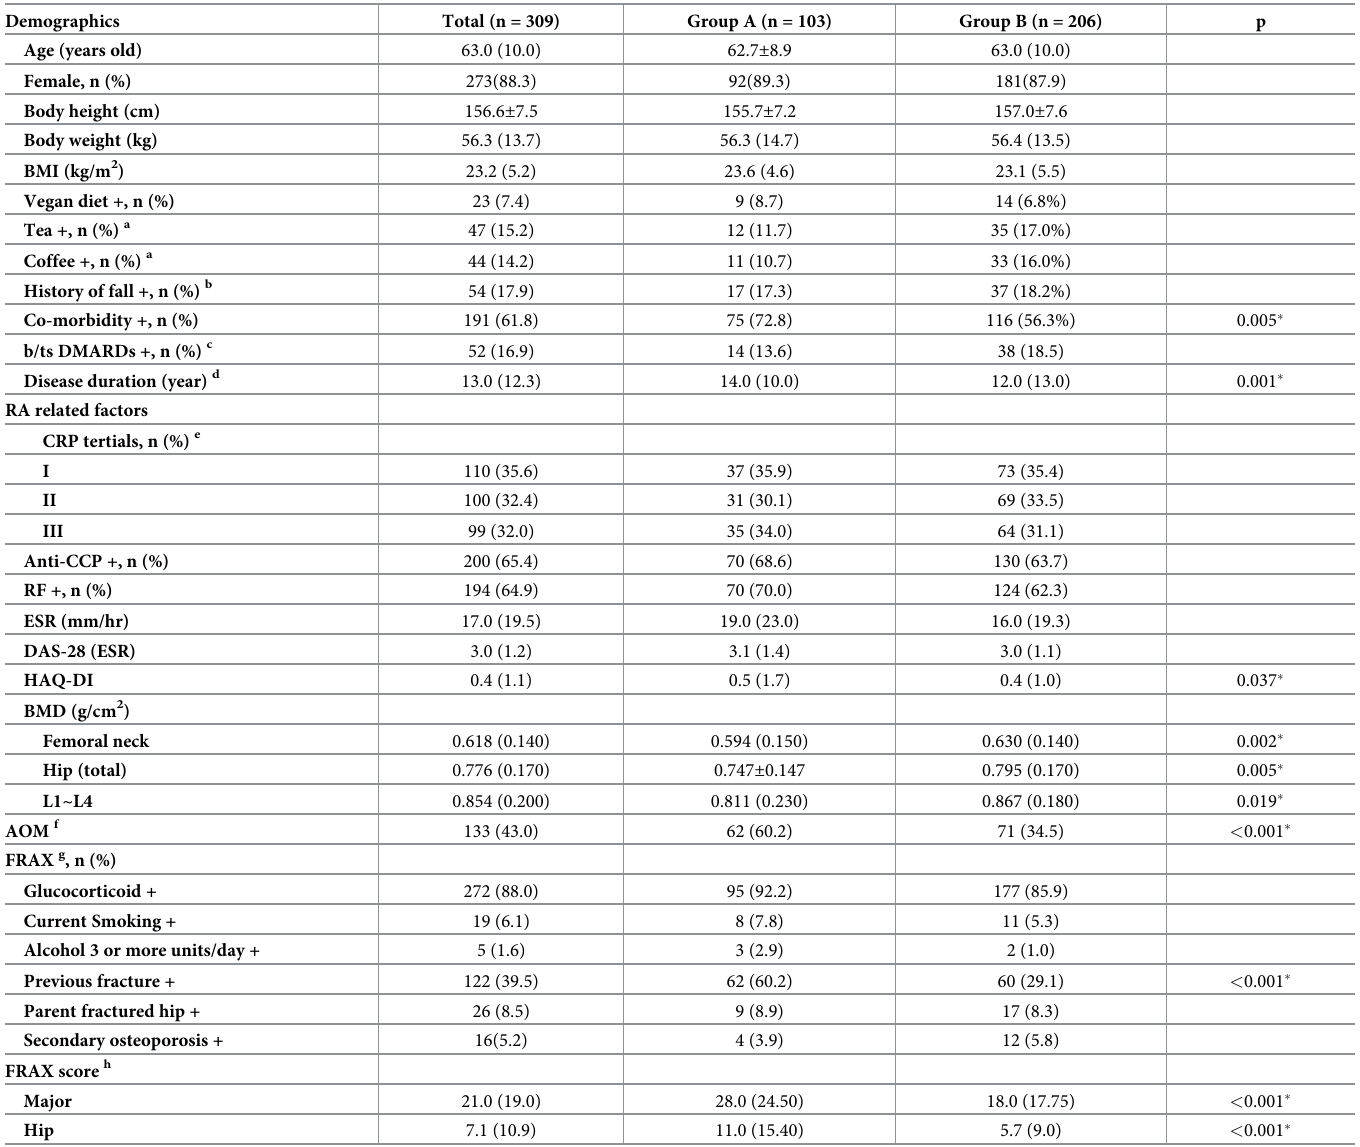
Table 3. Demographics and clinical characteristics of participants after